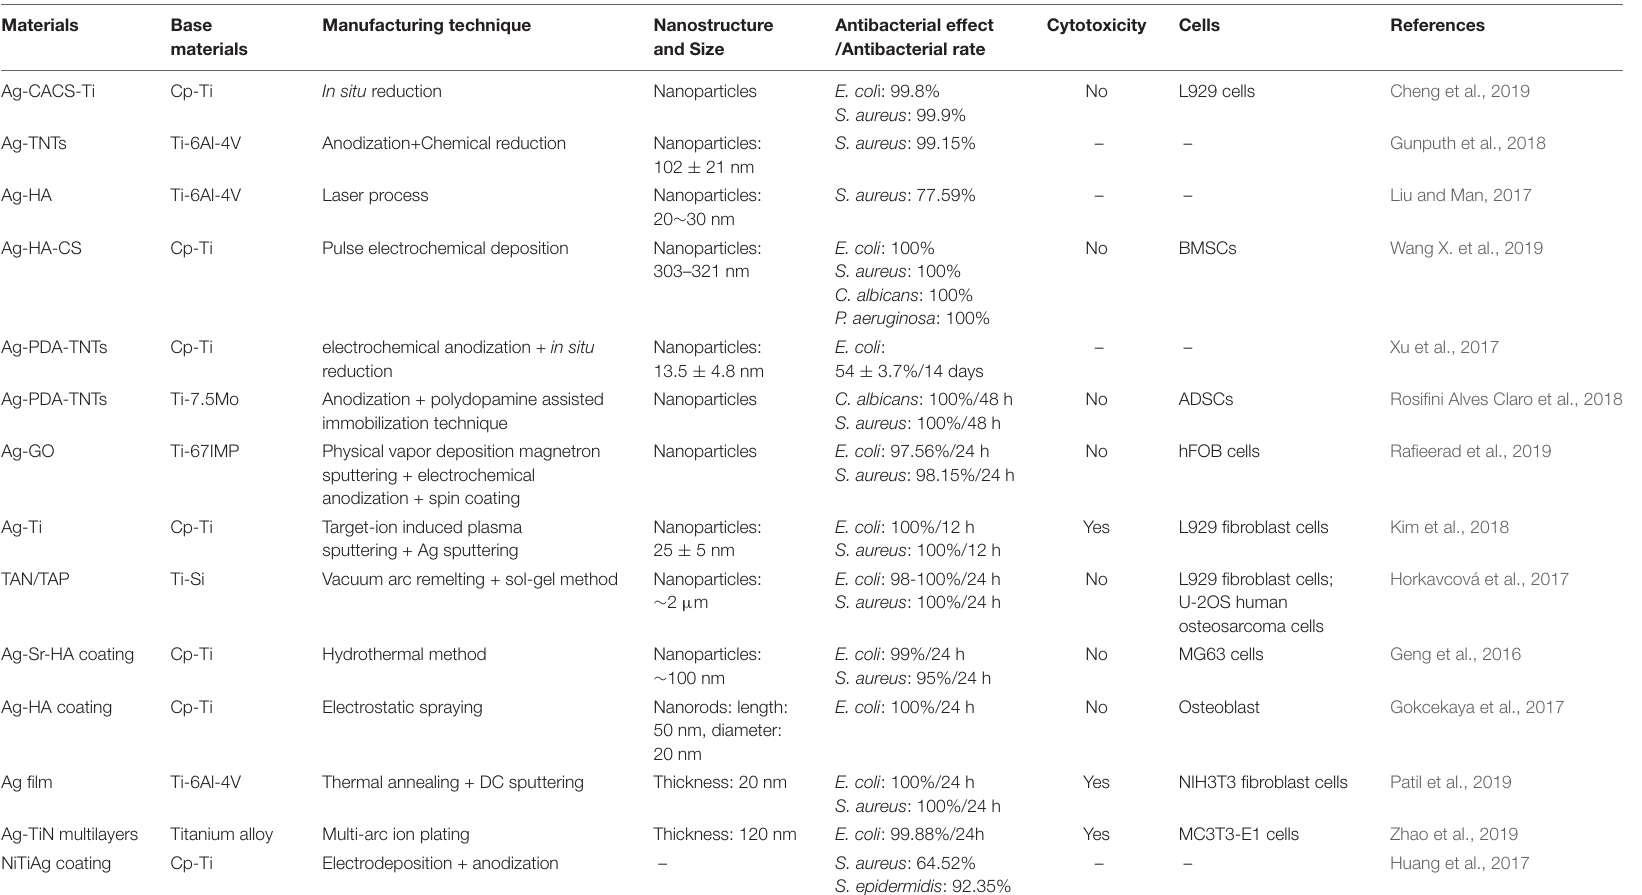
TABLE 3 | Antibacterial effects and other related information about different silver-containing nanomaterials.